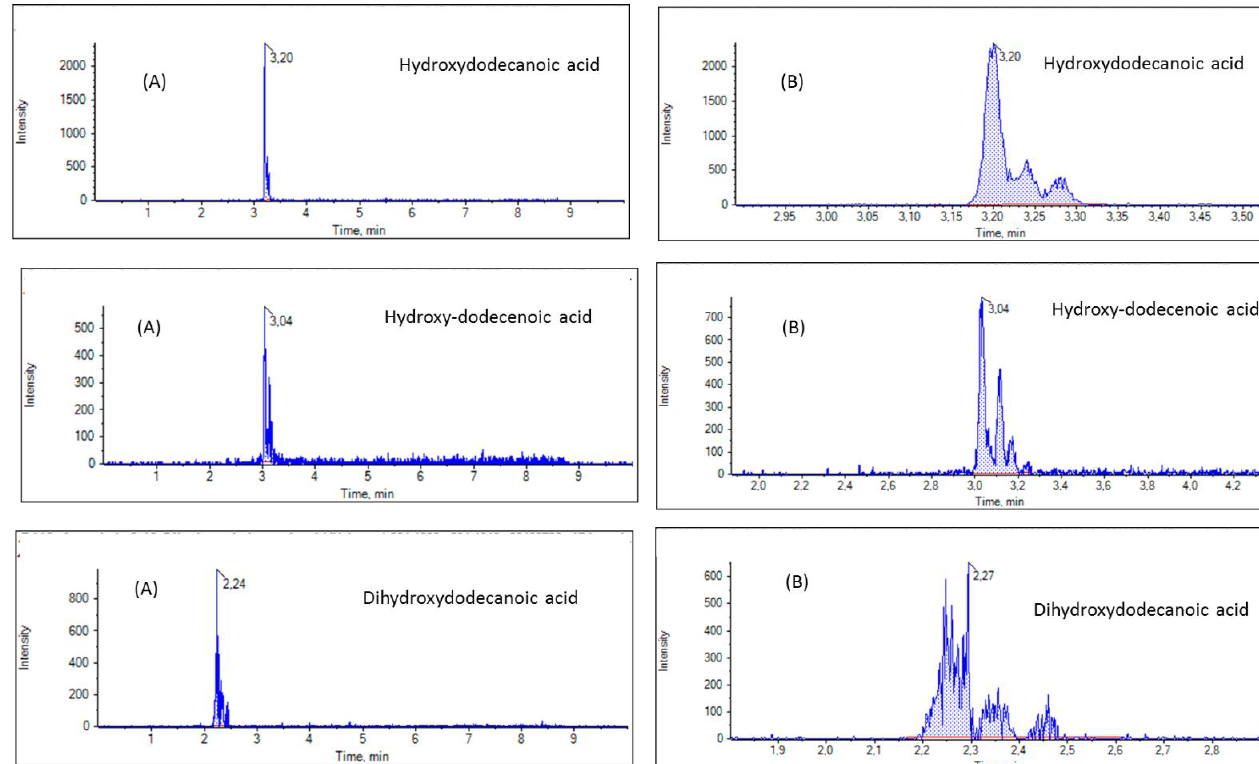
Figure 5. EICs of hydroxydodecanoic, hydroxydodecenoic and dihydroxydodecanoic acids ( A ) and zoom ( B ) in a representative RJ sample.